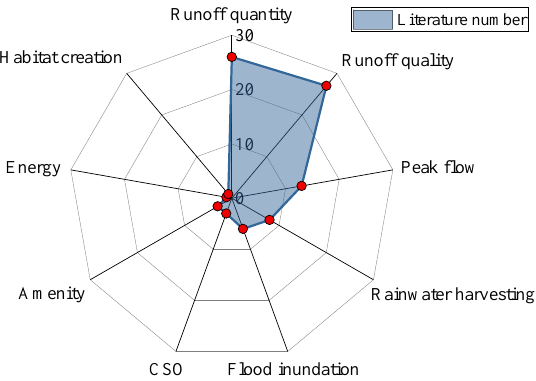
Figure 5. Plot showing functional indicators for GI and the number of studies involved.